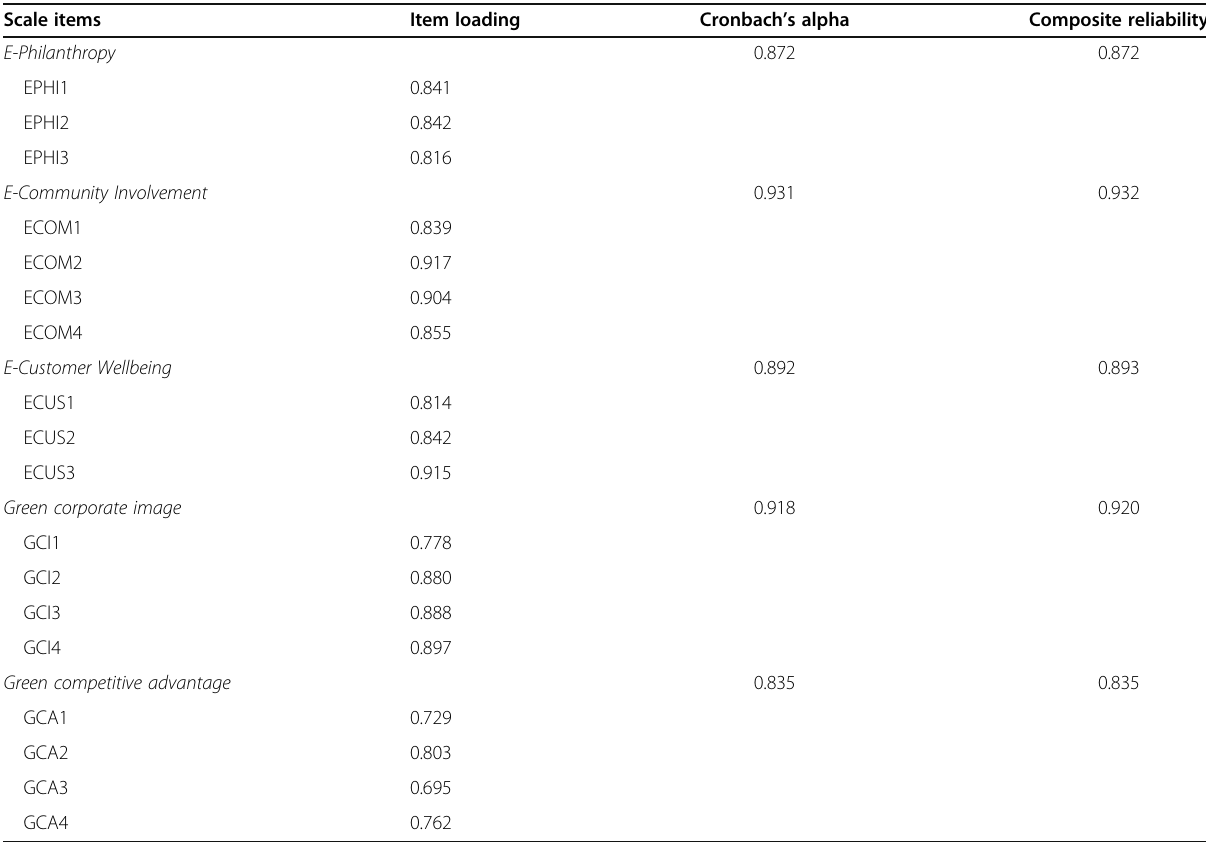
Table 2 Scale summary Scale